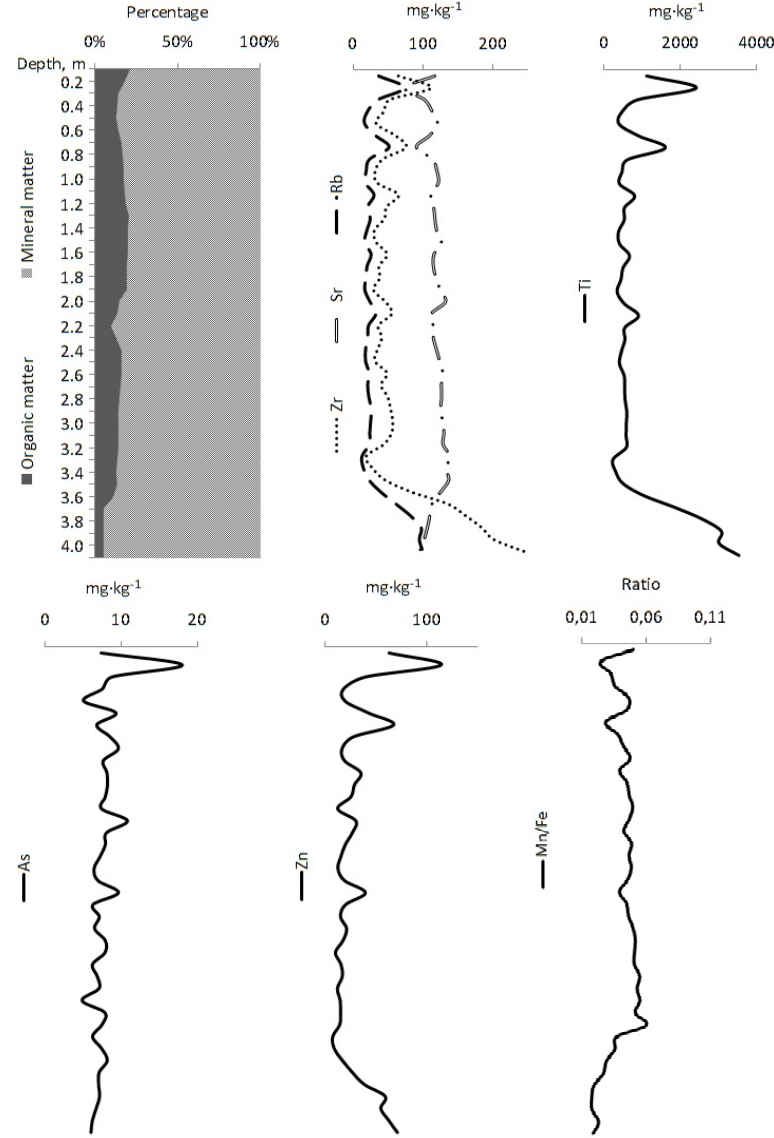
Figure 4. Main sediment components and concentrations of heavy metals in sediments of Lake Didžiulis.